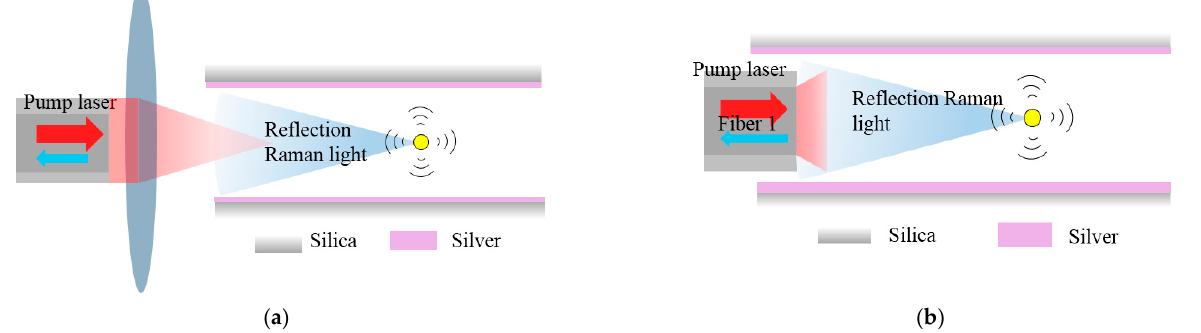
Figure 13. ( a ) The schematic diagram of free space coupling. ( b ) The schematic diagram of inserting coupling [10].